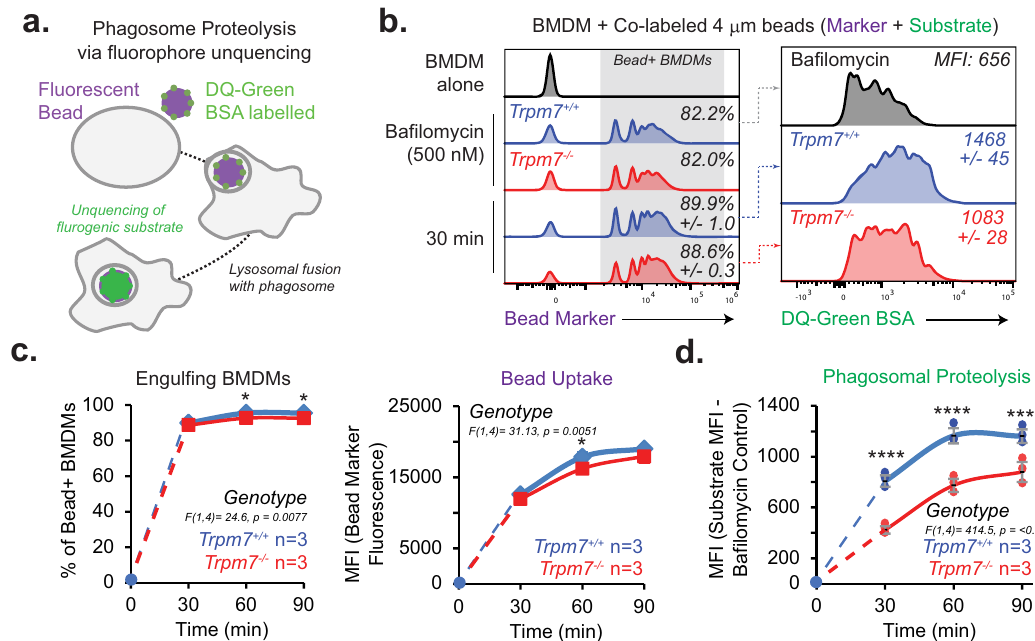
Fig. 5 TRPM7 regulates phagosome proteolysis in macrophages. a Schematic of phagosomal proteolysis assay. Fluorescent beads were conjugated to DQ green-BSA and then offered to BMDMs as cargo for phagocytosis. In bead-containing macrophages, lysosomal proteolytic activity was measured, as re fl ected by increased DQ-Green BSA fl uorescence due to proteolytic unquenching of the fl uorophore. b Flow cytometry-based measurement of proteolytic activity during phagocytosis of latex beads. DQ-green BSA-labelled fl uorescent beads (4 μ m) were incubated with WT and KO BMDMs for indicated time points. Left: Representative histograms of Bead + BMDMs. Right : Measurement of DQ-green MFI in Bead + BMDMs. Data representative of two independent experiments. c Quanti fi cation of bead uptake by Trpm7 + / + and Trpm7 − / − BMDMs. Left: Percentage of Bead + BMDMs over time. Right: Quanti fi cation of gross bead uptake measured by Bead MFI of Bead + BMDMs. Data points are mean of n = 3 independent samples. Error bars = SEM. d Quanti fi cation of the phagosomal proteolysis as shown in panel c . DQ-green BSA MFI is shown as change from Ba fi lomycin A1 pretreated BMDMs (negative control) and gated on Bead + BMDMs. Individual sample data points are plotted. Error bars = SEM. Source data are provided as a Source Data fi le, and statistical testing is described in “ Statistics and Reproducibility ”